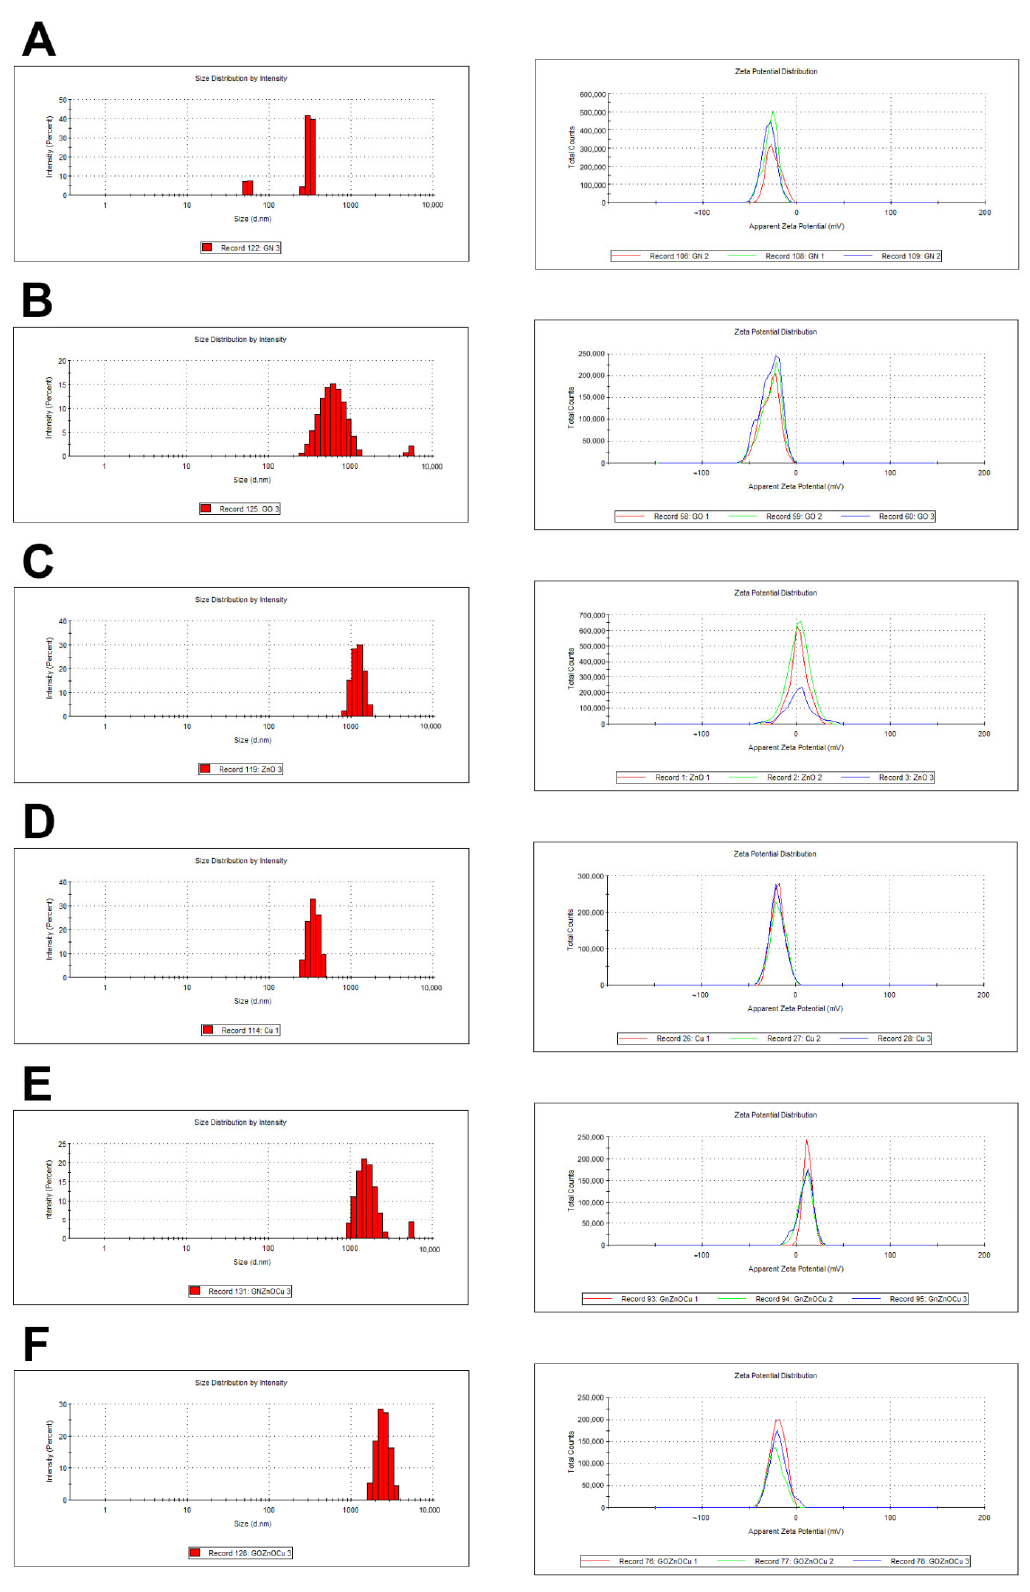
Figure 1. Physicochemical analysis (mean average and zeta potential, respectively) of nanoparticles: ( A ) GN; ( B ) GO; ( C ) ZnO; ( D ) Cu; ( E ) GNZnOCu; ( F ) GOZnOCu. The mean average was measured by DLS, and the zeta potential was measured by ELS. Three different colors mean